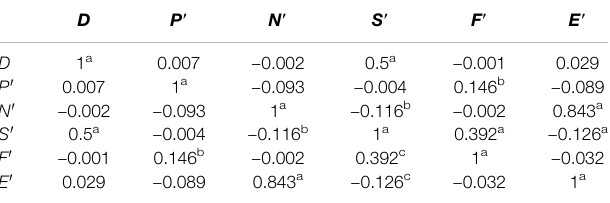
TABLE 6 | Data on the relationships of driving factors using the QAP